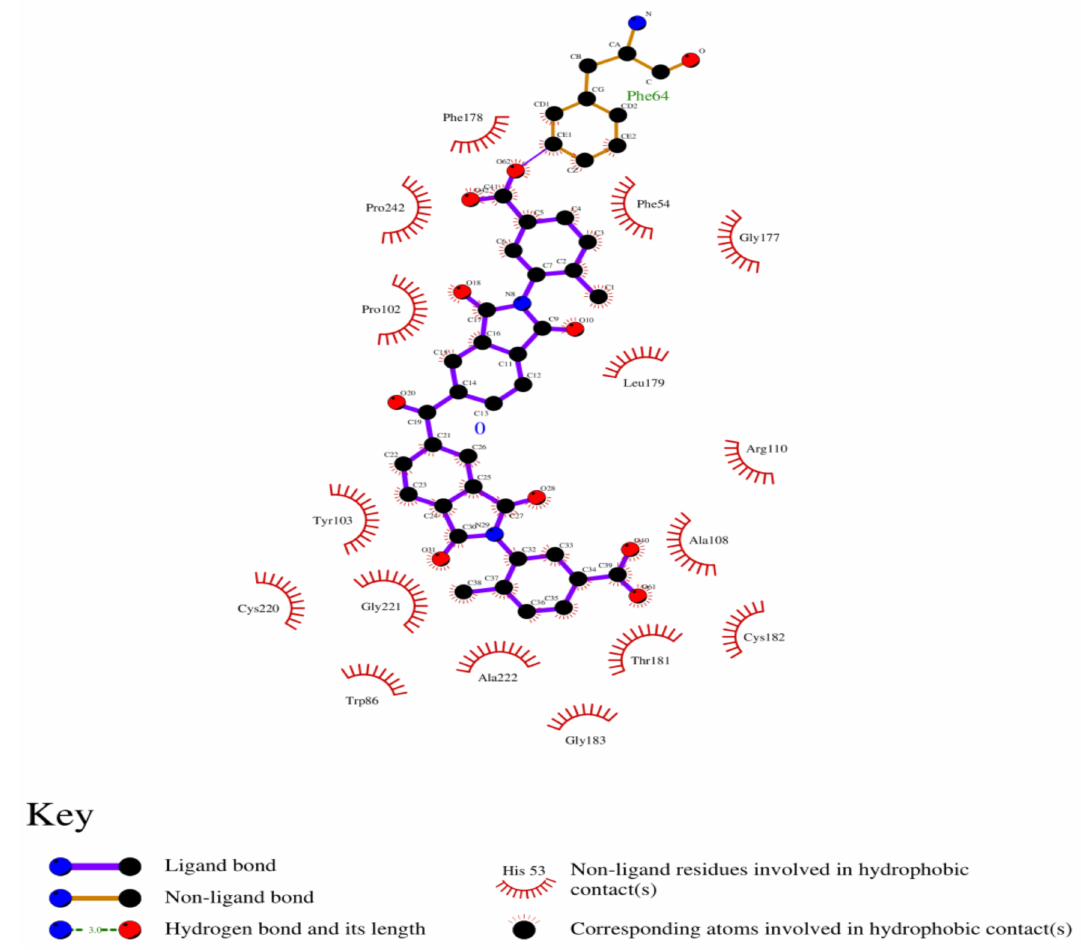
Figure 10. 2D interaction of ethyl N-[2,4,6-trioxo-1-(2-phenylethyl)-5-(trifluoromethyl)-7H-pyrrolo[2,3-d]pyrimidin-5- yl]carbamate and HCV E2